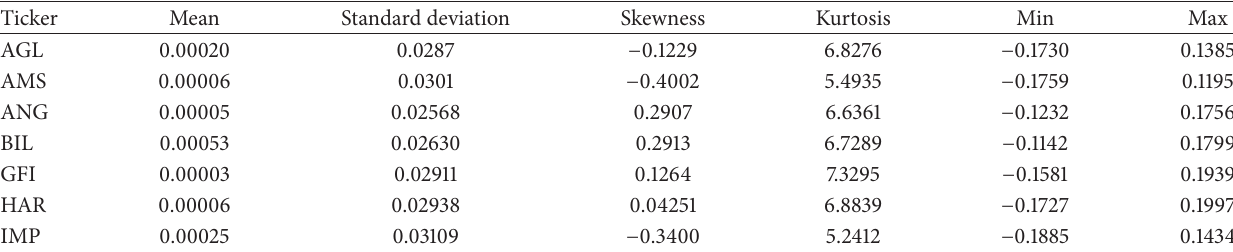
Table 1: Descriptive